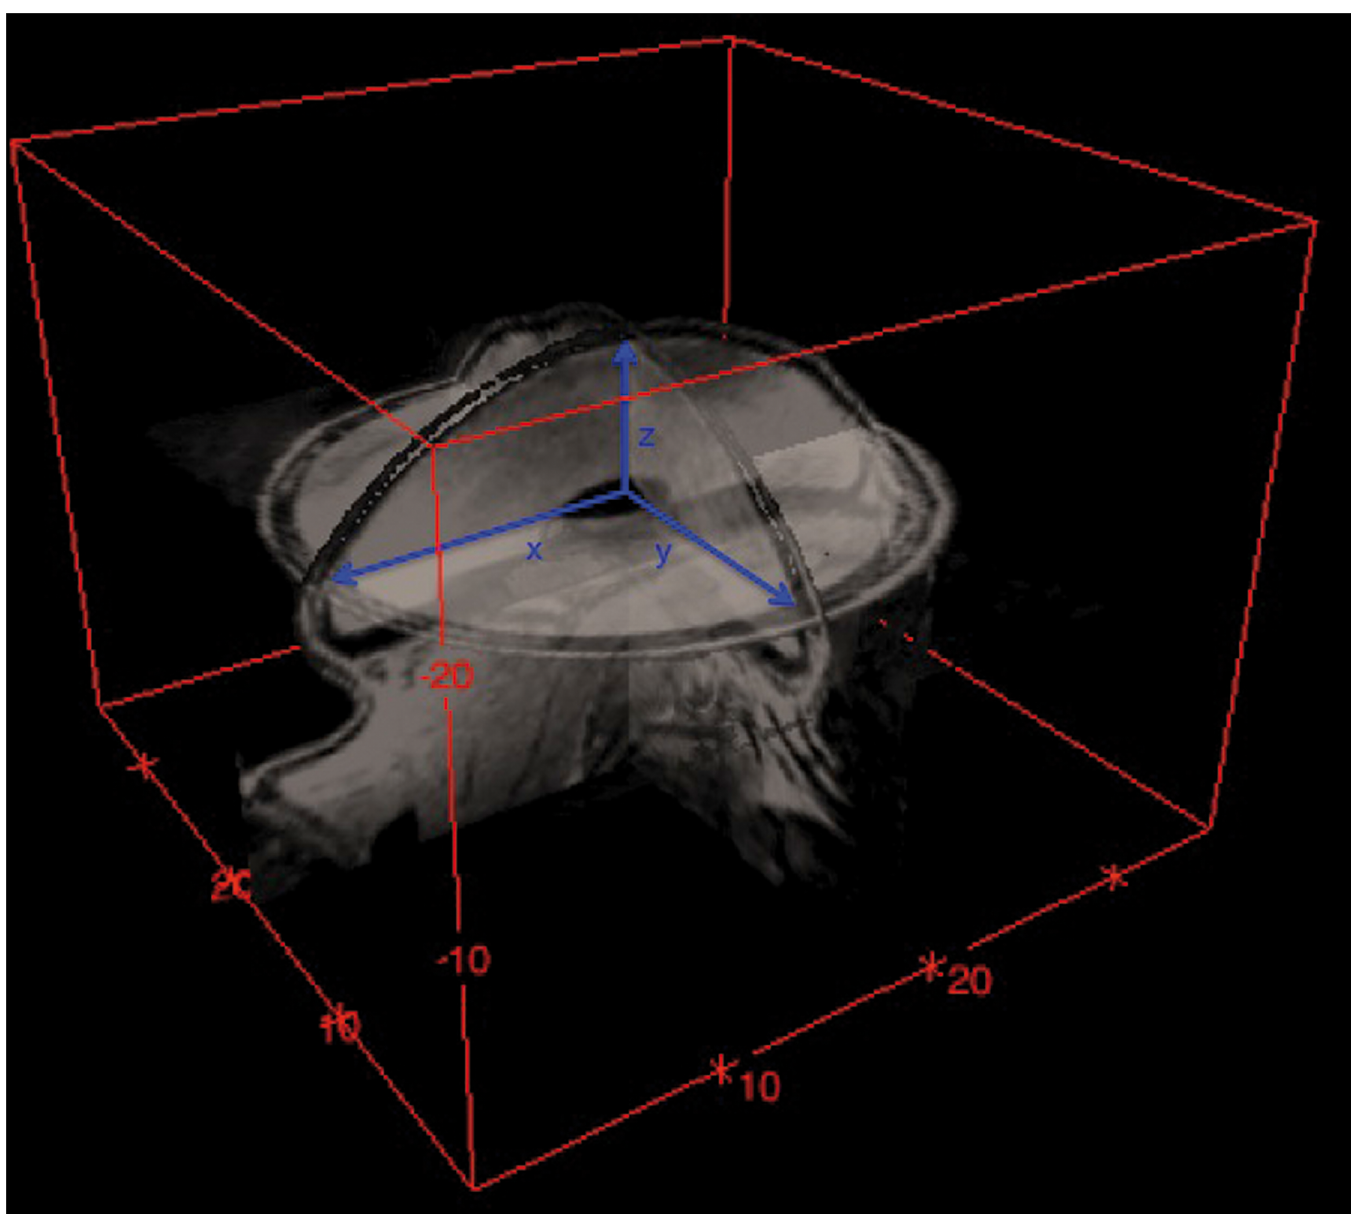
Fig 4. Example picture of MR image after 3D reconstruction and displayed as multi-orthoslice. Measurements were performed at the x-, y- and z-axis (blue arrows). Scale was adjusted automatically by the